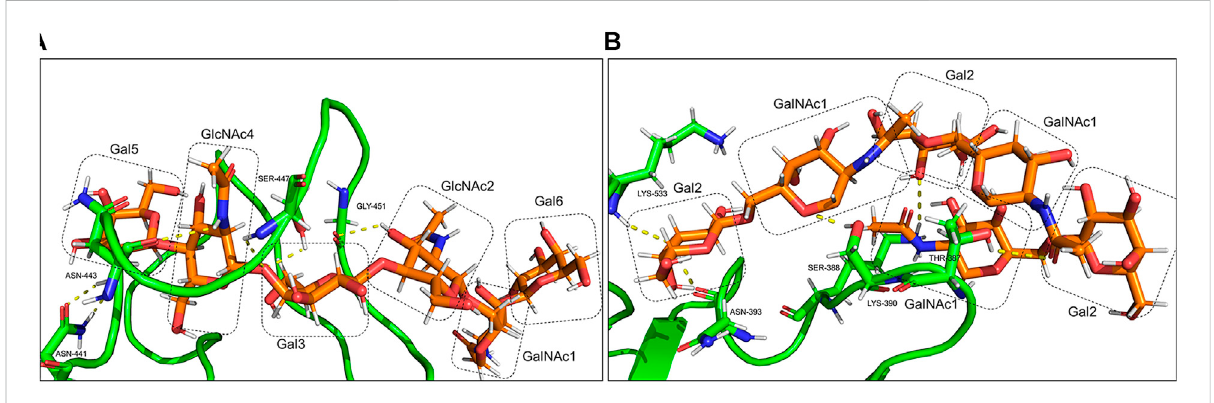
FIGURE 12 Intra-hydrogen bonds between glycans and the amino acids of gmRBD are shown in yellow dots. (A) O-glycan attached to Ser494 and (B) O-glycans core attached to Ser386,388 and Thr 387.